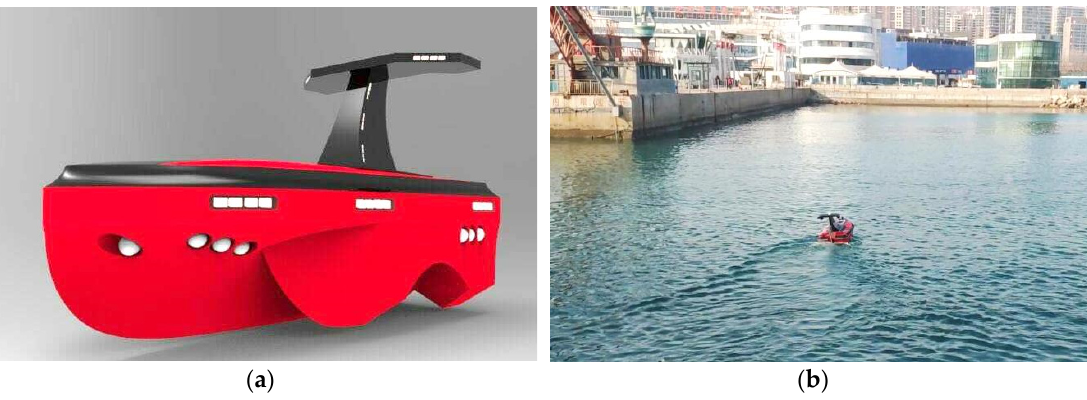
Figure 6. A self-developed unmanned surface vehicle: ( a ) 3D model; ( b ) USV in water.